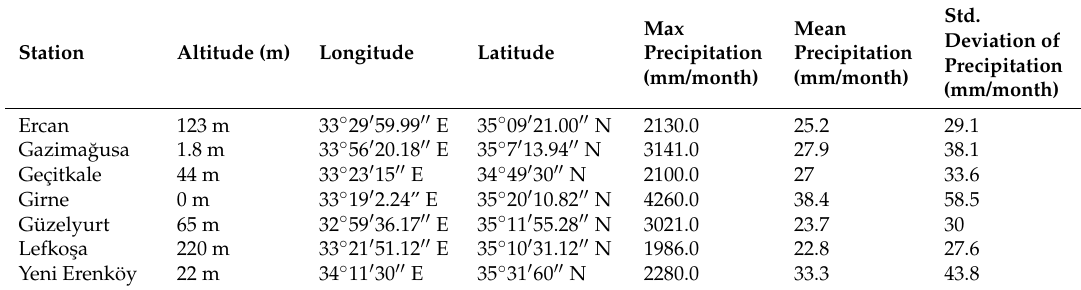
Table 2. The characteristics of stations and statistics of the precipitation